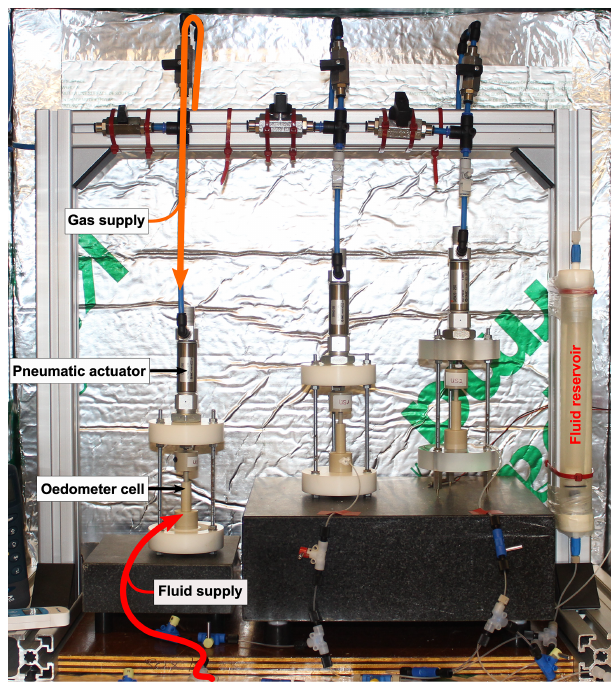
Figure 2. Experimental setup for oedometric compaction experi- ments conducted at the University of Edinburgh. Three samples could be loaded simultaneously. Oedometer cells contained the cylindrical samples and were confined in straining frames during deformation. The load was applied by gas-driven pneumatic actu- ators installed at the top of each frame. Cetoni neMESYS high- pressure syringe pumps were used to supply saturated NaCl brine via a fluid reservoir in order to maintain a pore fluid pressure suffi- cient to suppress gas bubbles in the samples. For the second experi- mental suit we replaced the fluid reservoir and high-pressure pump with a brine-filled syringe that was driven by another pneumatic ac- tuator (not shown here). The oedometer cells were placed on acous- tically dampened gabbro blocks to avoid external vibrations to reach the